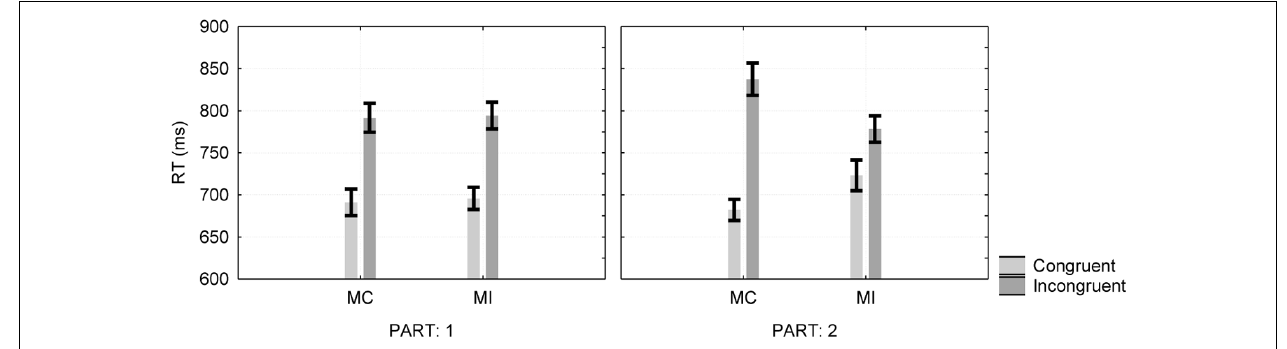
FIGURE 2 | Item-specific proportion congruent effect as a function of instruction type and experimental part in Experiment 2. Error bars are one standard error of the mean. MC, mostly congruent; MI, mostly